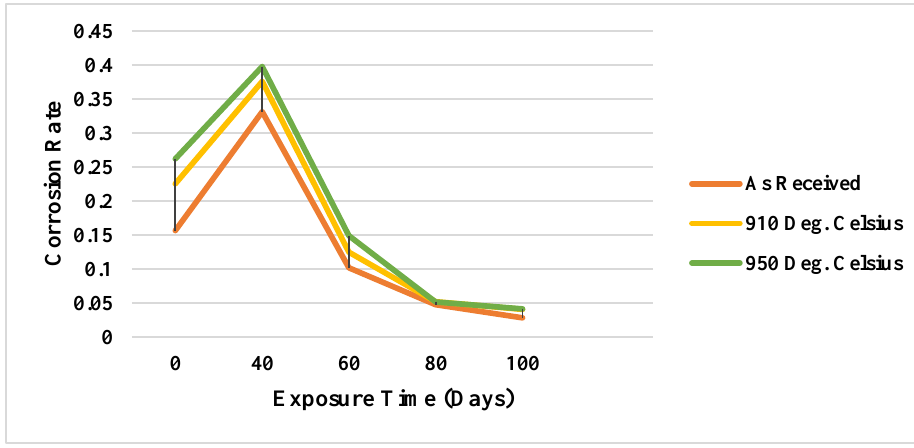
Fig. 1. Corrosion rate against exposure time for un-welded annealed medium carbon